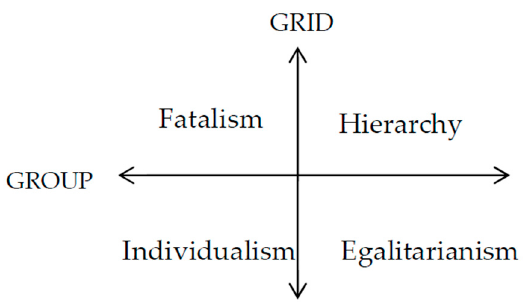
Figure 2. Dake’s (1992) “grid-group” risk culture type quadrant.